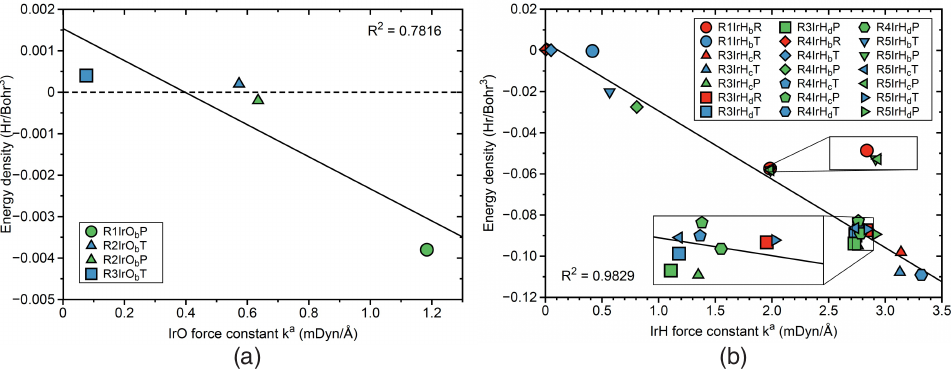
(b) Figure 15. Correlation between energy density H ρ and local mode force constant k a . ( a ) IrO bonds; ( b ) IrH bonds. label such as R1IrO b R, R1IrO b T, and R1IrO b O indicate reactant RE (red color), TS (blue color), and product PR (green color) IrO b bond in R1 . Similar notation for reactions R2 – R5 . For the bond label description see the text. B3LYP/6-31G(d,p)/SDD(Ir) level of